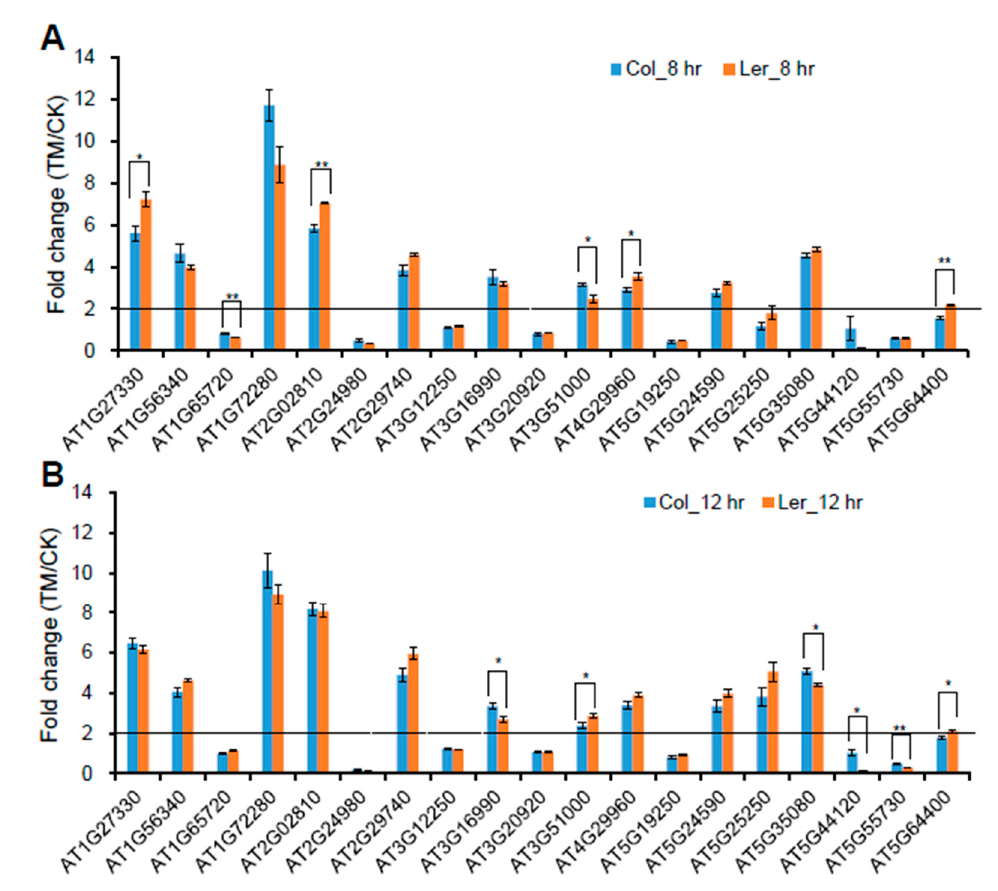
Figure 6. Expression analysis of genes encoding the differentially regulated proteins by ER stress between Col and L er plants. ( A , B ) Ten-day-old Col and L er seedlings grown on ½ MS plates were treated without or with 5 µ g / mL tunicamycin (TM) for 8 h ( A ) or 12 h ( B ), and total RNA was extracted for quantitative RT-PCR (RT-qPCR). Fold change is the expression level of genes in TM-treated plants divided by that in control (CK) plants, both of which were normalized to the expression of ACTIN . Error bars represent SE ( n = 3). Asterisks indicate significance levels when comparing two ecotypes in t -test. (* p < 0.05; ** p < 0.01).